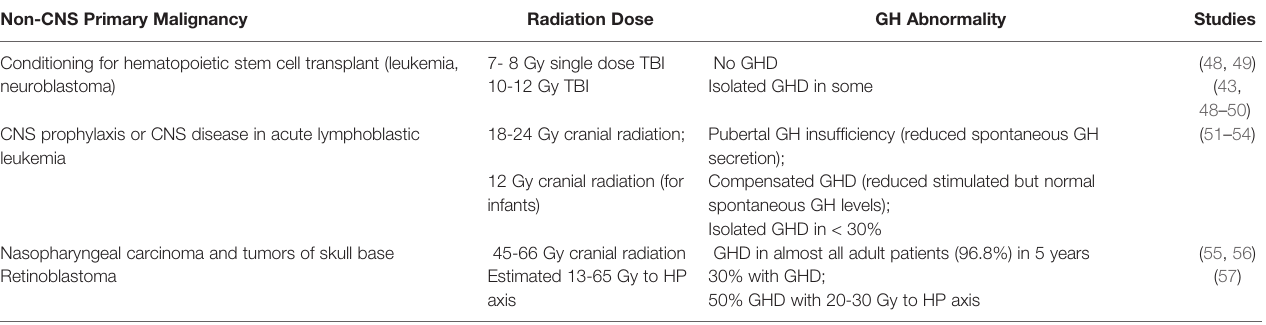
TABLE 2 | Cranial radiation therapy and growth hormone de fi ciency in non-central nervous system